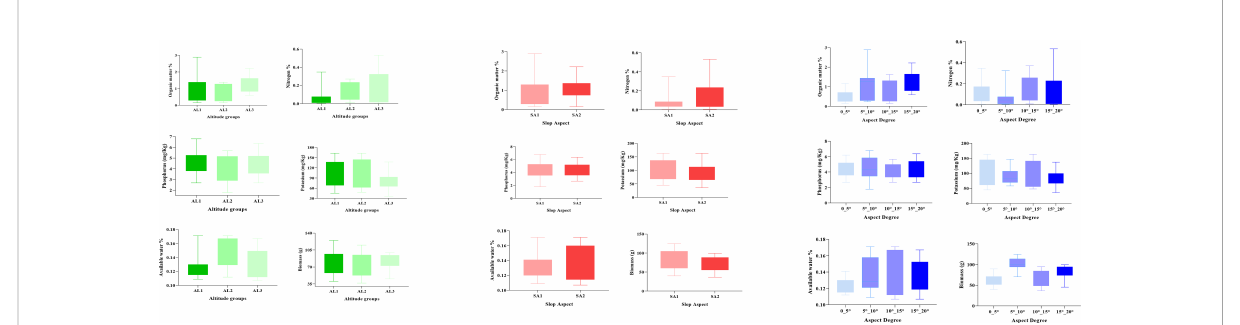
FIGURE 2 Relationship between topographic conditions and soil variables for C. procera . Error bars represent stand deviation. Low altitude (AL1), middle altitude (AL2), high altitude (AL3), Slope aspect (south-facing and North-facing slope), Aspect degree (0-5°, 5°-10°, 10°-15°,